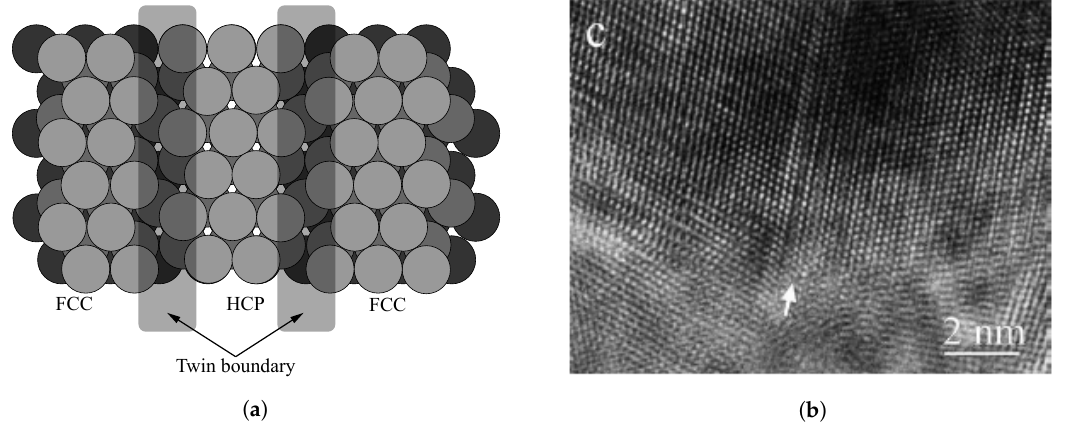
Figure 5. ( a ) Diagram of the twin boundary caused by partial dislocation and ( b ) twin boundary in an FCC lattice due to the tensile loading observed in reference [7,17].